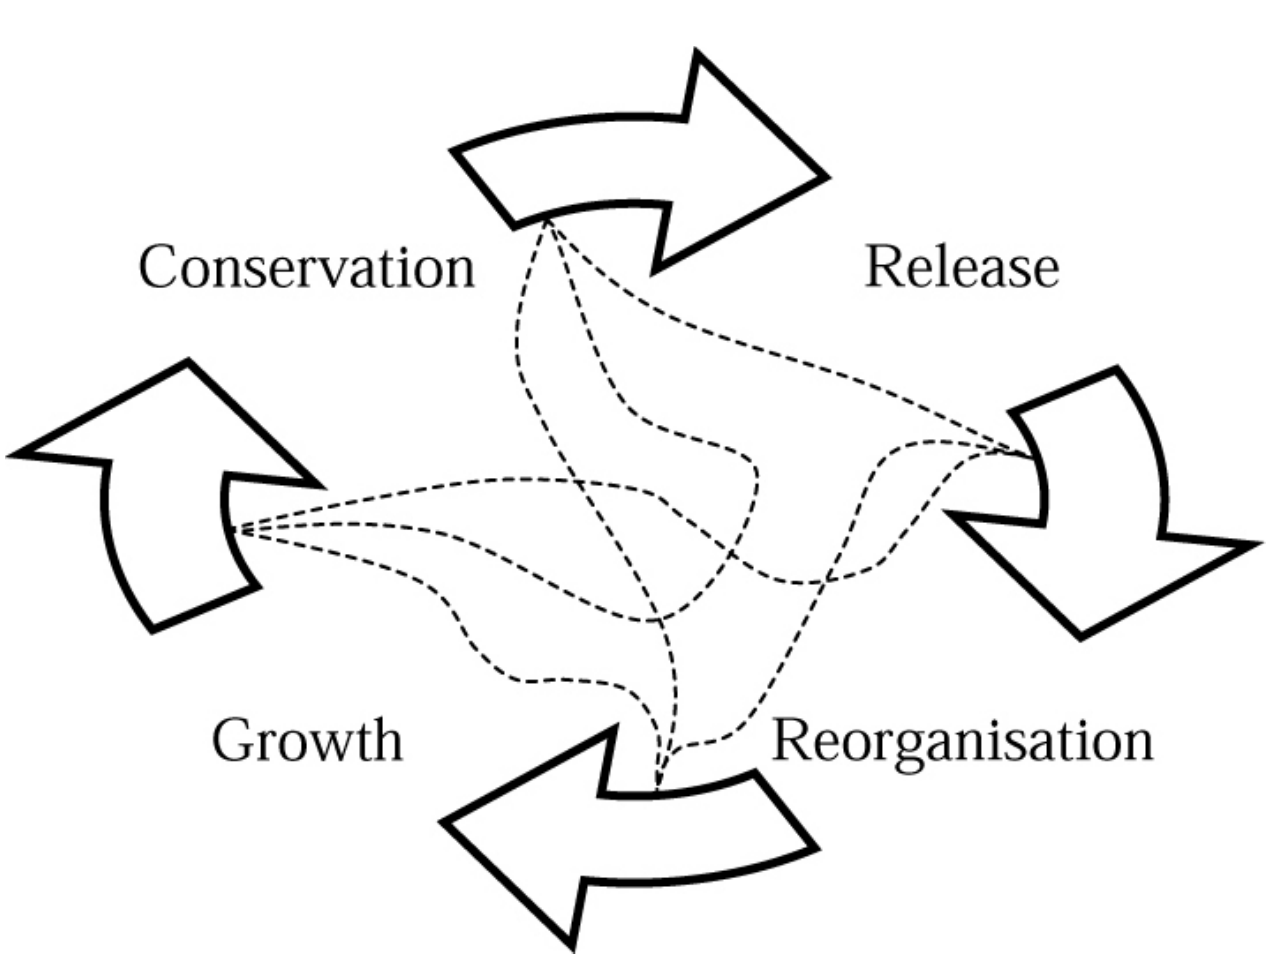
Fig. 1. The “Adaptive Cycle” holds that systems move through a sequence of states (large arrows), though the exact sequence may vary (indicated by thin